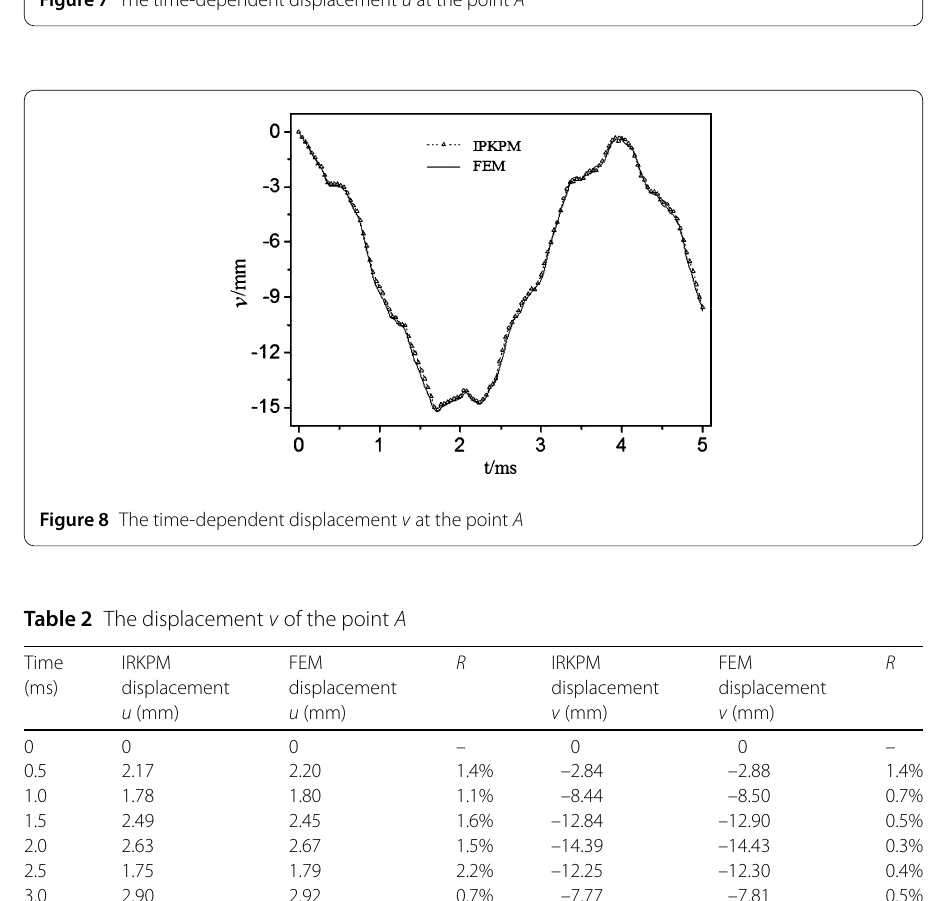
Figure 7 The time-dependent displacement u at the point A